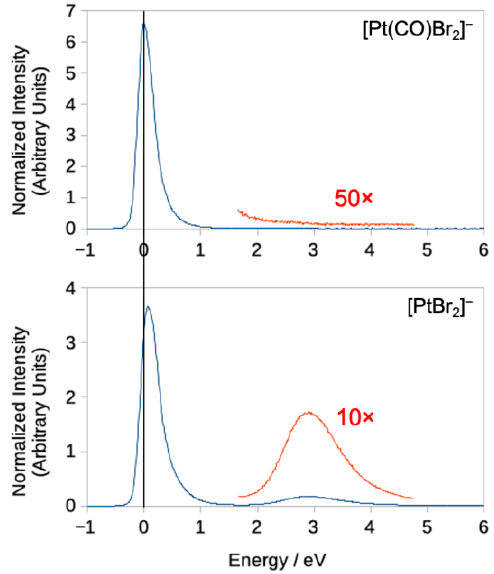
Figure 1. Negative ion yields for the loss of one and two CO ligands. Top : loss of one CO ligand; bottom : loss of two CO